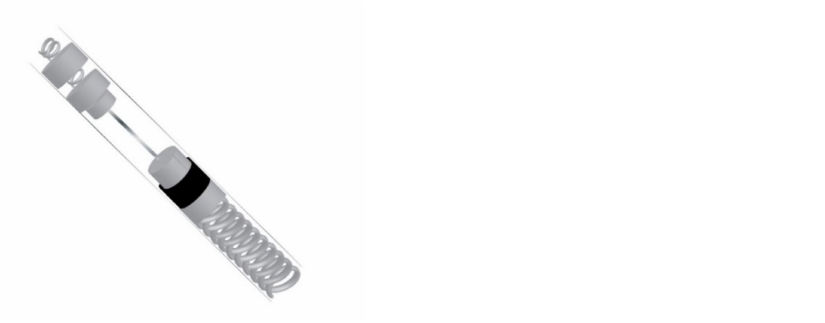
Figure 2. Simplified cross-section of an implantable cardioverter-defibrillator